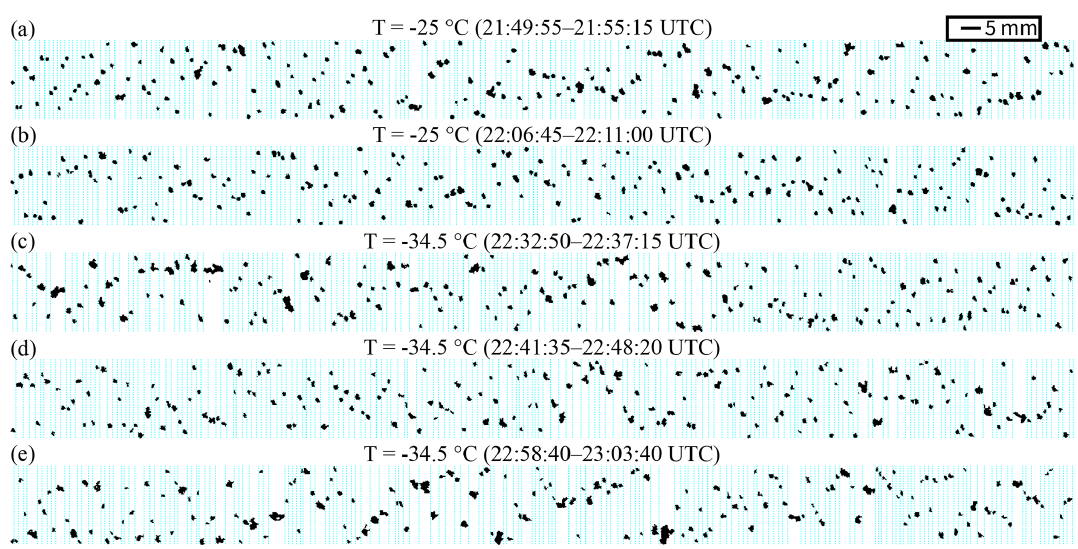
Figure 15. Same as in Fig. 10, but for the 23 May 2011